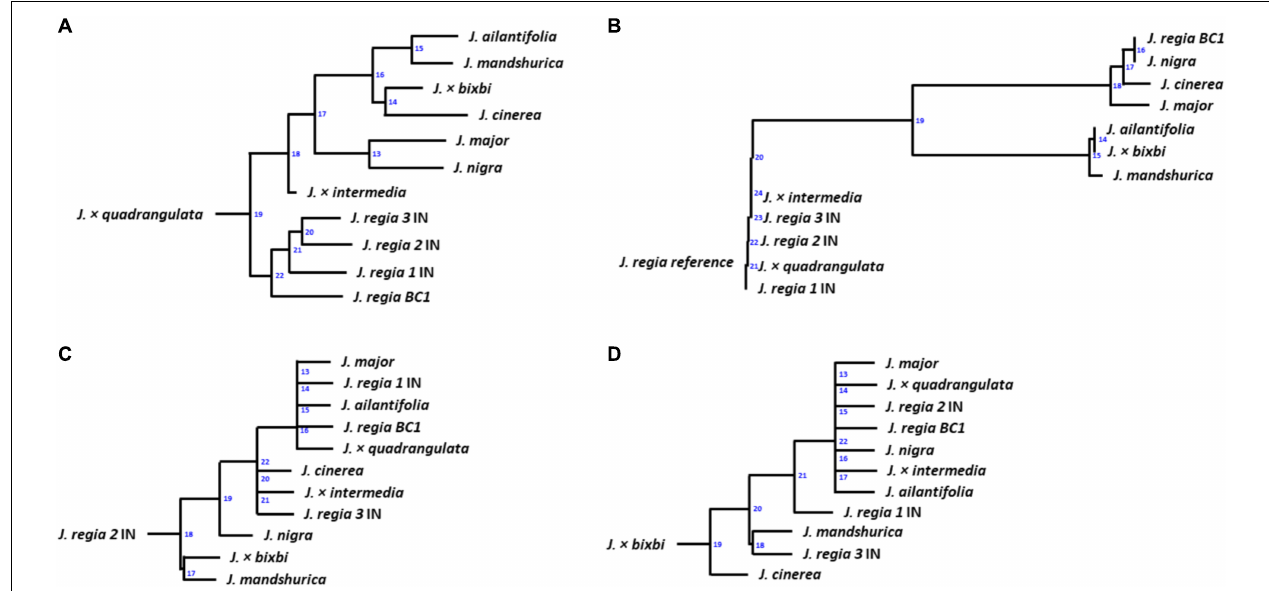
FIGURE 5 | Dendrograms for samples of 12 Juglans : (A) based on whole nuclear genome; (B) based on chloroplast genome (C) based on whole proteins; (D) based on DREB-like genes filtered from the whole genome annotation. Numbers on transfers indicate the order of inference (Boc et al., 2012) for Juglans